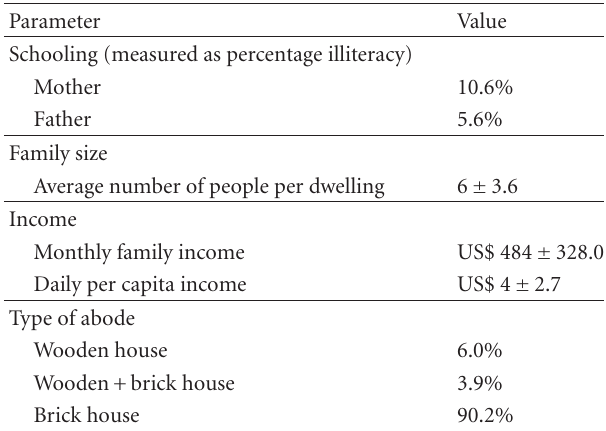
Table 1: Socioeconomic characteristics of the study